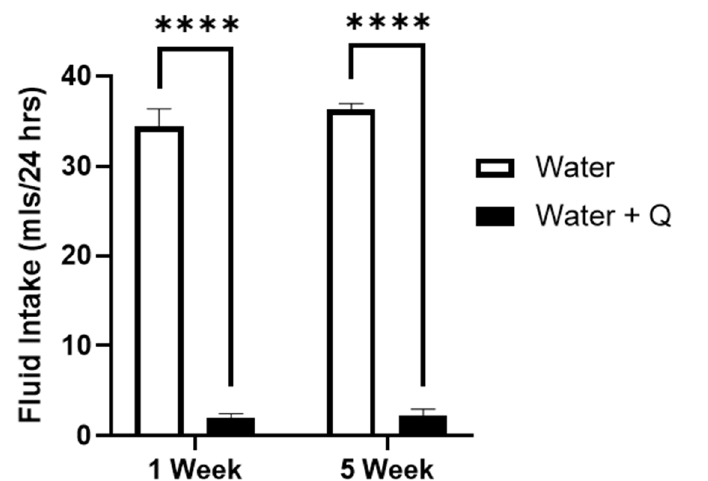
Figure 6. Quinine sensitivity in water. Male P-rats consumed EtOH under free-choice conditions for 1 week (left, n = 8) or 5 weeks (right, n = 7), then were tested under two-bottle choice conditions, with one bottle containing water, and the second bottle with 0.1 g/L quinine in water. Rats in both groups highly preferred water alone compared to the water adulterated with 0.1 g/L quinine ( t -values > 16; **** p < 0.0001).